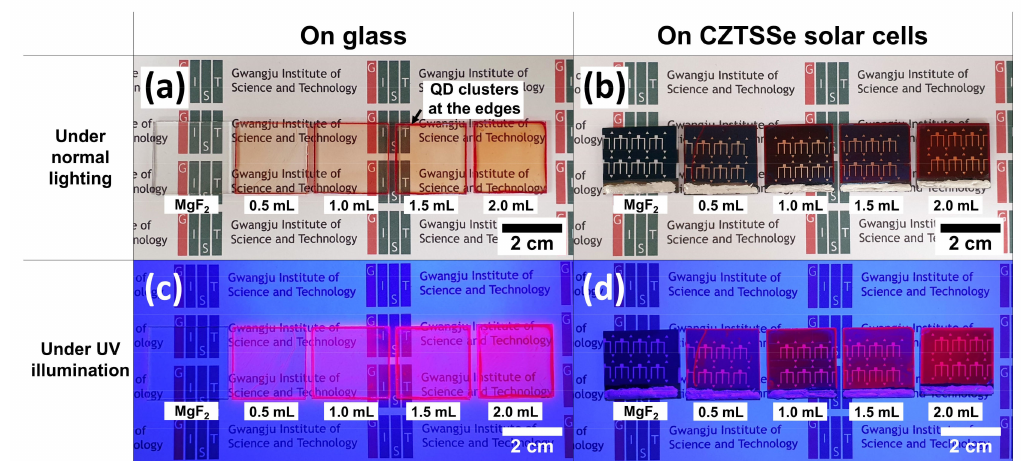
Figure 5. Digital camera images of the QD-based LDS layers under ( a , b ) normal lighting and ( c , d ) ultraviolet (UV) illumination on glass and CZTSSe thin-film solar cells. All the samples were capped with the MgF 2 antireflection coating.